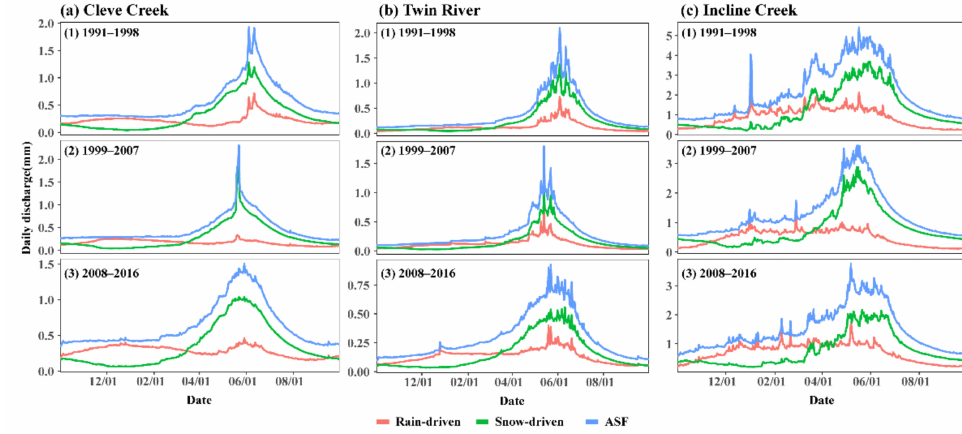
Figure 7. Annual streamflow and partitioned snow-driven and rain-driven streamflow